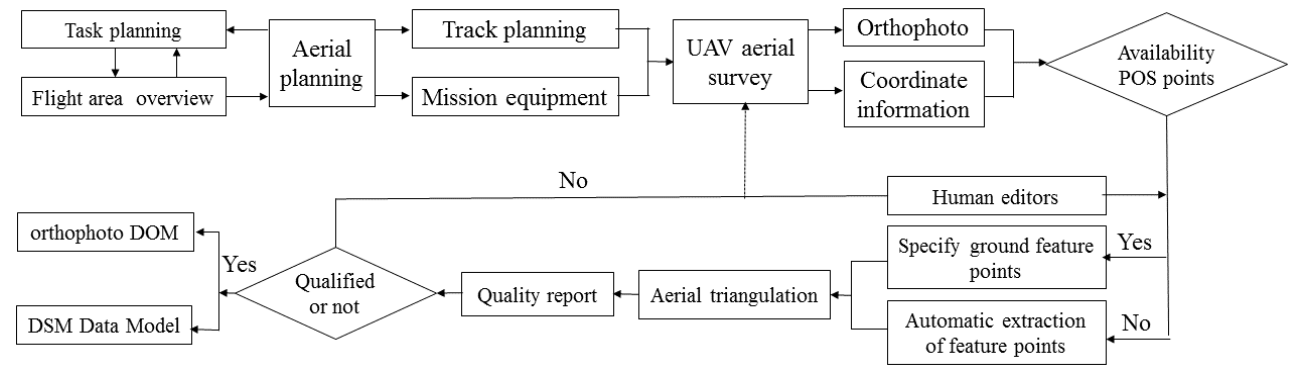
Figure 3. UAV aerial survey data acquisition and internal data processing.